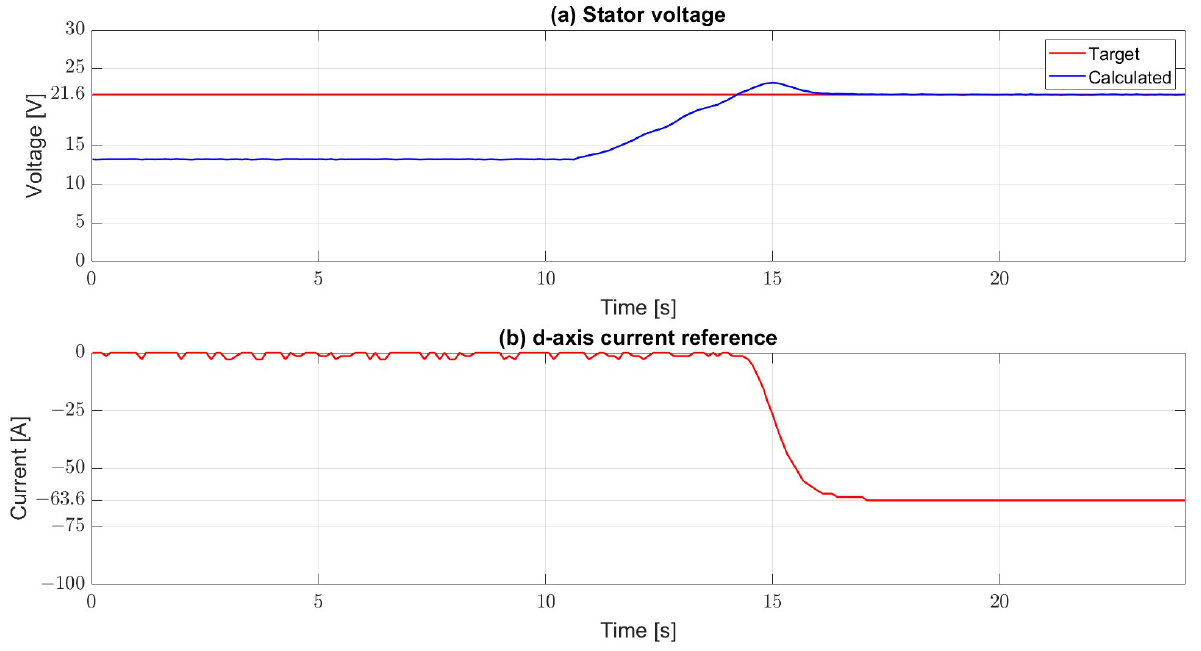
Figure 29. ( a ) Stator voltage and ( b ) d-axis current reference for the field weakening operation